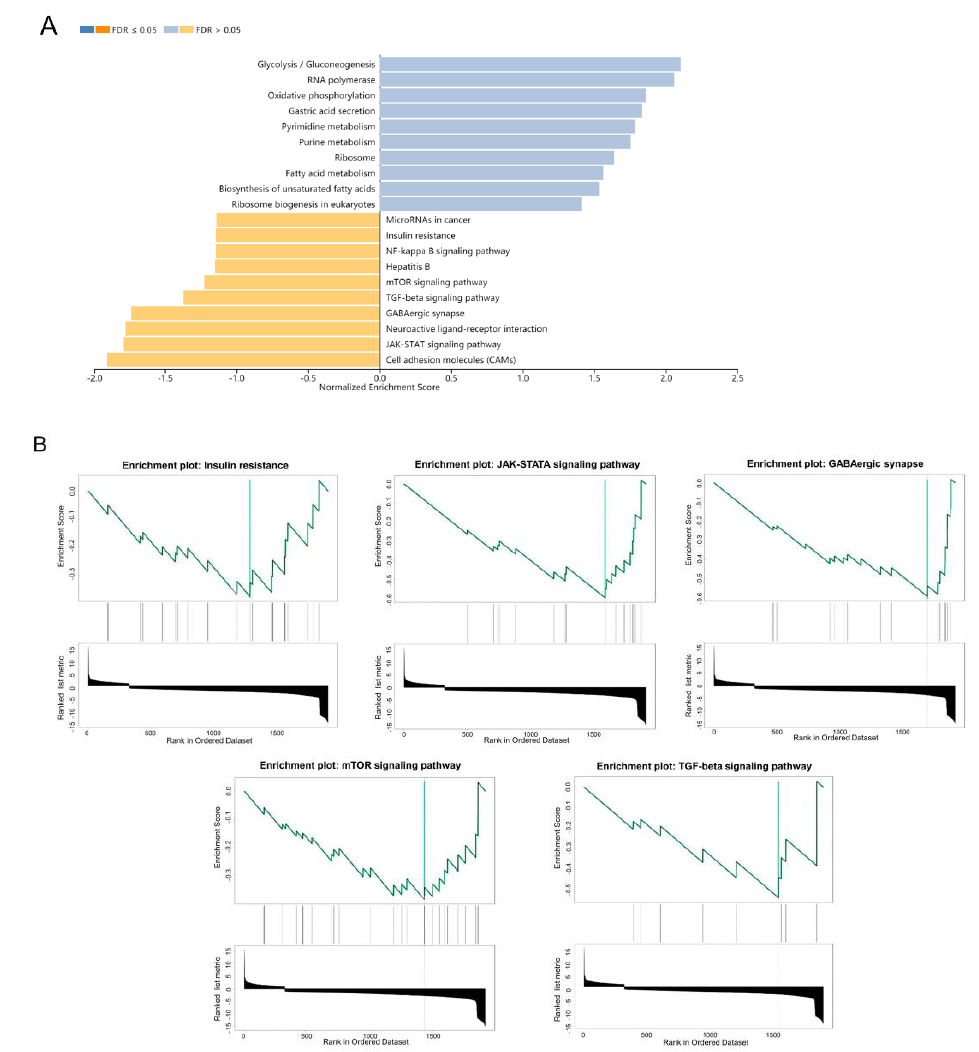
Figure 1. Identification of biological pathways associated with the difference in growth performance between Bama minipigs and Landrace pigs. ( A ) Top 10 enrichment results of DEGs based on the KEGG pathway database. ( B ) GSEA plot for five KEGG signaling pathways in the log2 fold change for whole transcriptome.